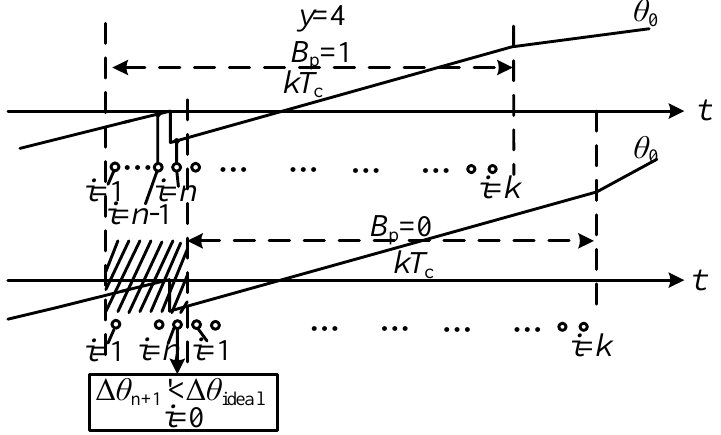
Figure 7. The change of θ 0 with and without the NDZ elimination method.